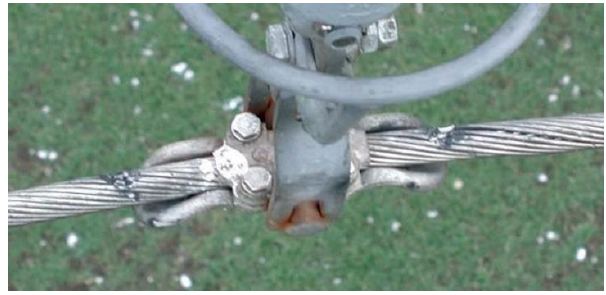
Figure 13. Transmission conductor damaged by lightning [21].